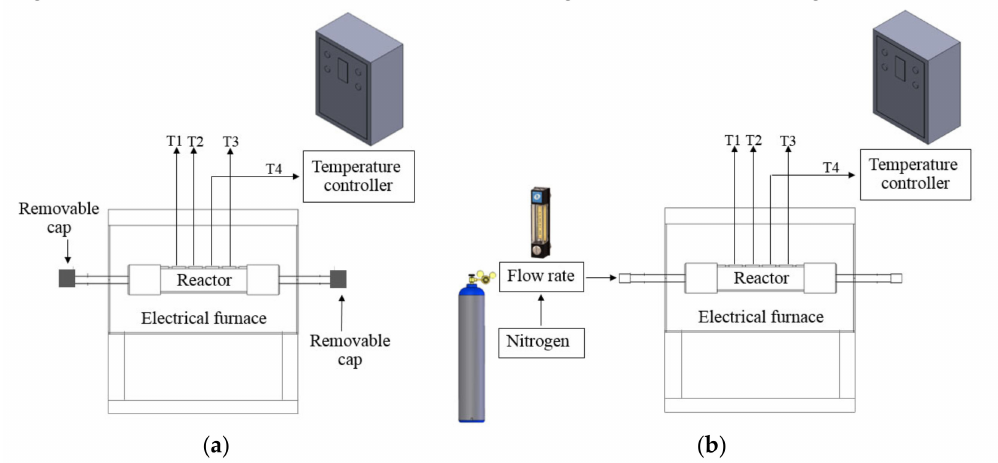
Figure 3. Laboratory-fixed bed torrefaction reactor. ( a ) Torrefaction without purge gas; ( b ) Torrefaction with nitrogen as purge